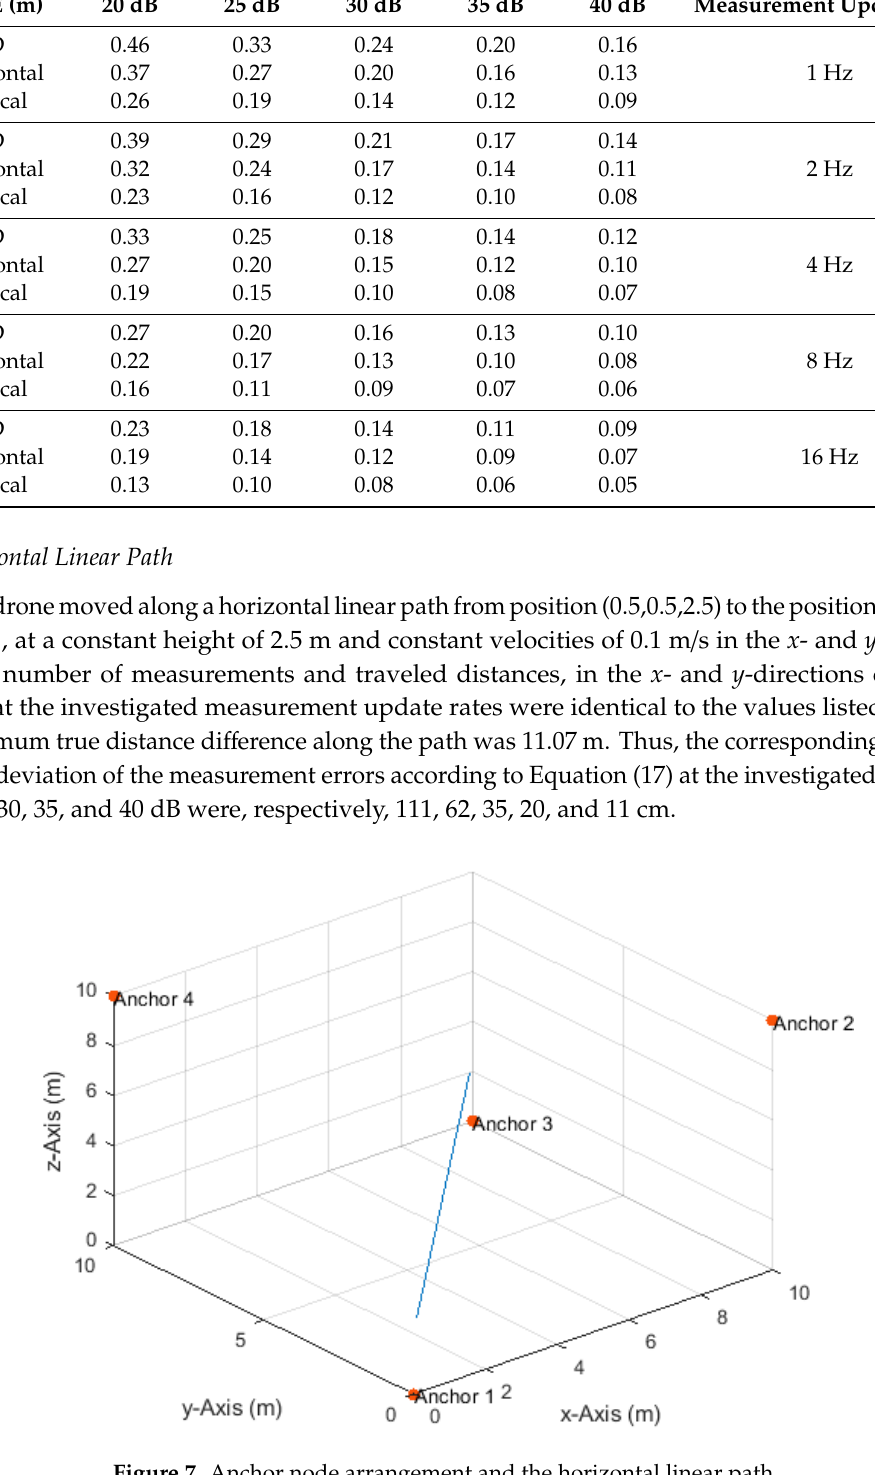
Figure 7. Anchor node arrangement and the horizontal linear path.